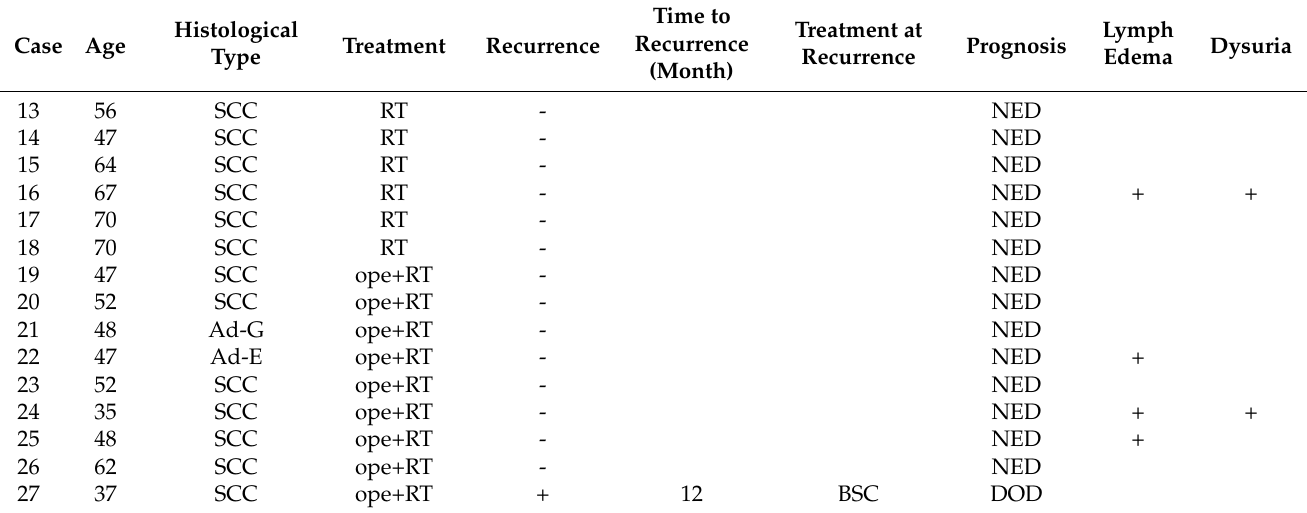
Table 2. Stage IIIC1 cases classified as T2 by the TNM classification of the Union for International Cancer